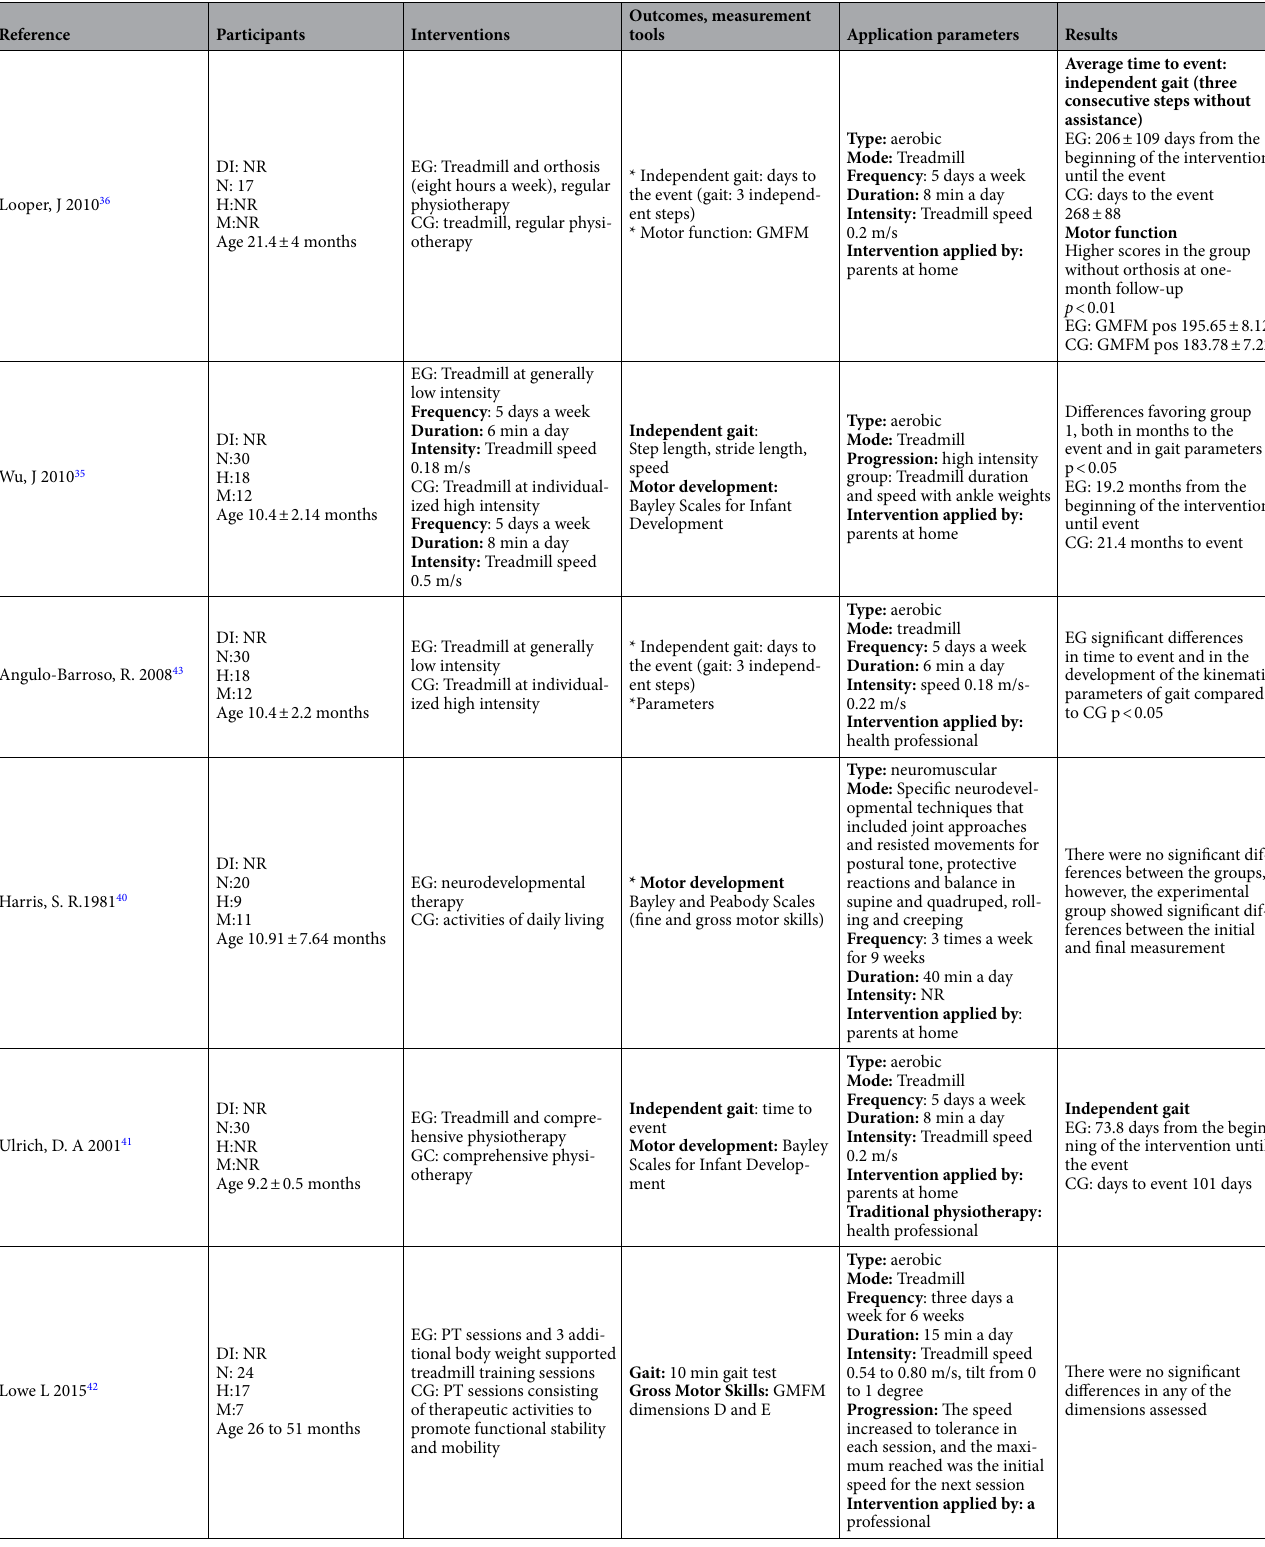
Table 2. Characteristics of the studies included regarding therapeutic exercise in children with DS aged 0 to 3 years. GMFM: Gross Motor Function Measure; EG: experimental group; CG: control